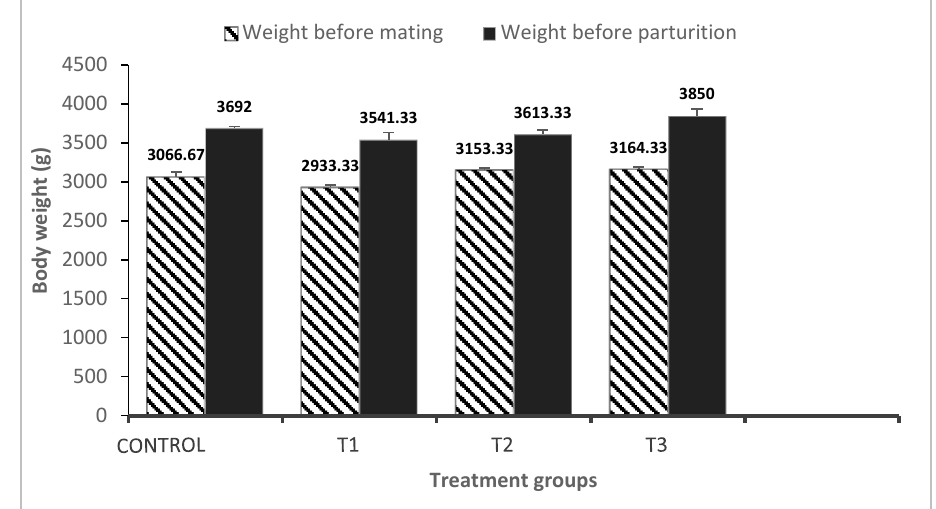
Figure 1. Effect of pomegranate peel and garlic powder separately or in combination on the weight of does. Values are presented as means ± SE (n = 5 litters). T1; pomegranate peel 3%, T2; garlic 3%, and T3; pomegranate peel 1.5% + garlic 1.5%. There are significant differences between before and after parturition.